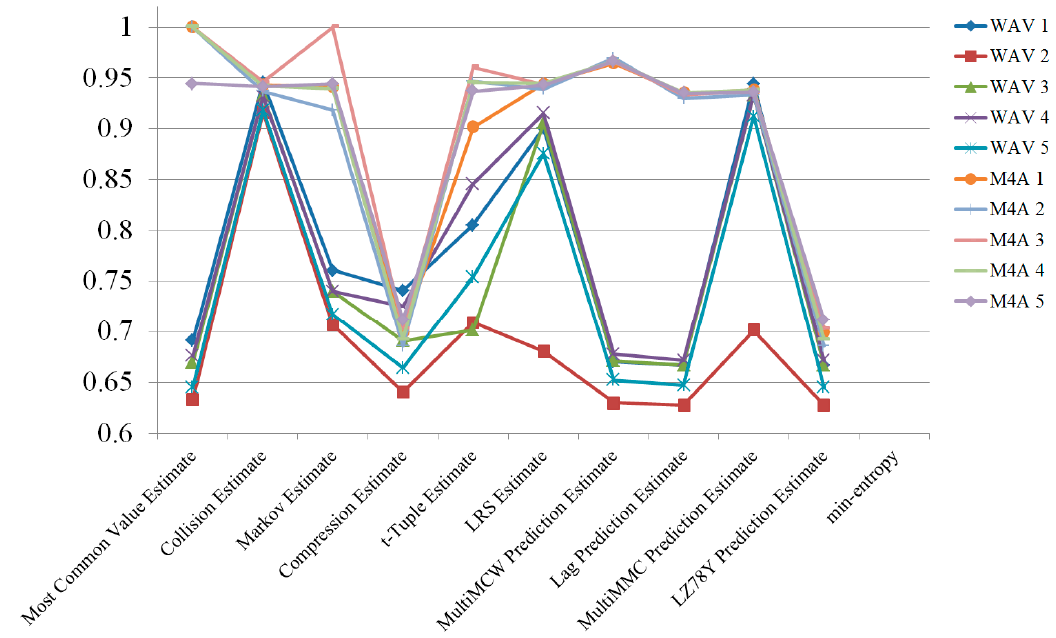
Figure 6. Randomness estimation results of radio signals collected with 1 s delay.